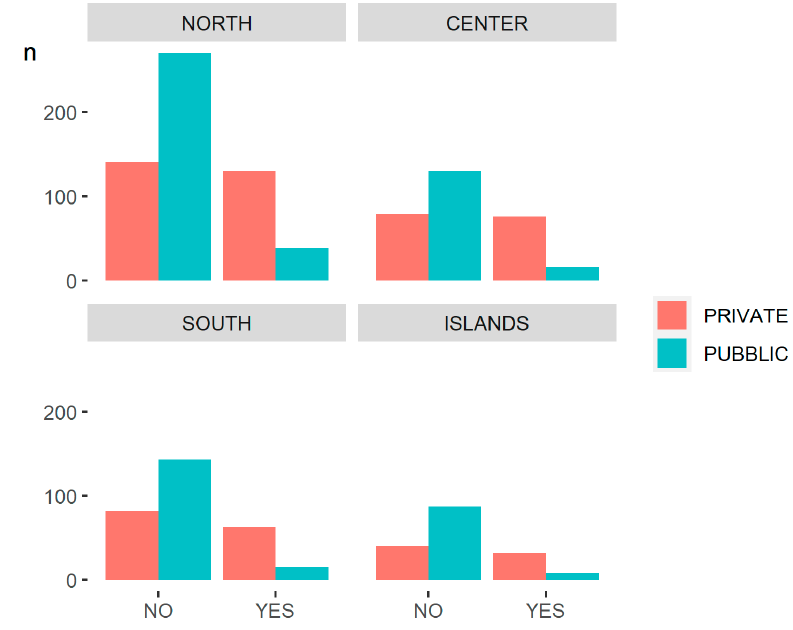
Figure 2. Bar diagram differentiated by geographical area.